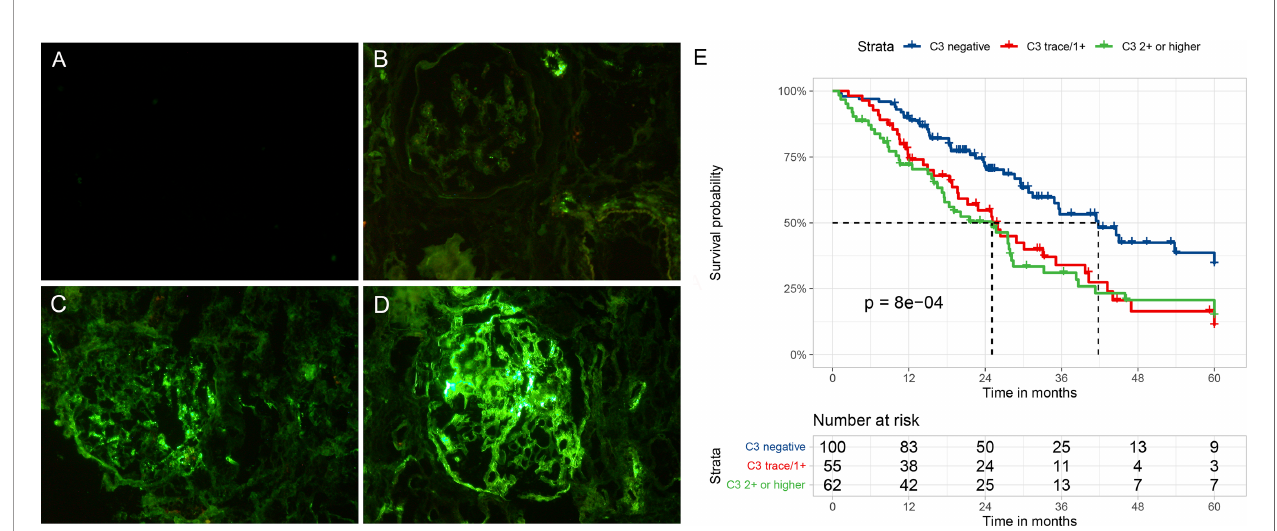
FIGURE 2 | Representative immuno fl uorescent staining (A – D) for C3 in patients with diabetic nephropathy and Kaplan – Meier survival curve (E) for a composite of end-stage renal disease, ≥ 50% decline in initial eGFR, or death according to glomerular C3 deposits. (A) No C3 staining (C3 – ), (B) seemingly visible at low magni fi cation but clearly visible at high magni fi cation (C3+), (C) clearly visible at both low and high magni fi cation (C3 2+), and (D) clearly visible at low magni fi cation but dazzling at high magni fi cation (C3 3+).